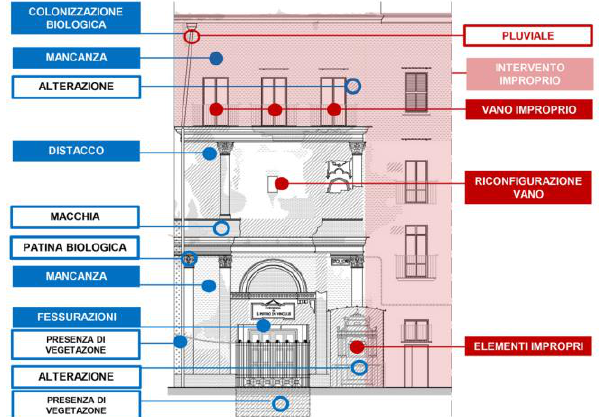
Figure 3 . Facade of Church of San Pietro in Vinculis , decay